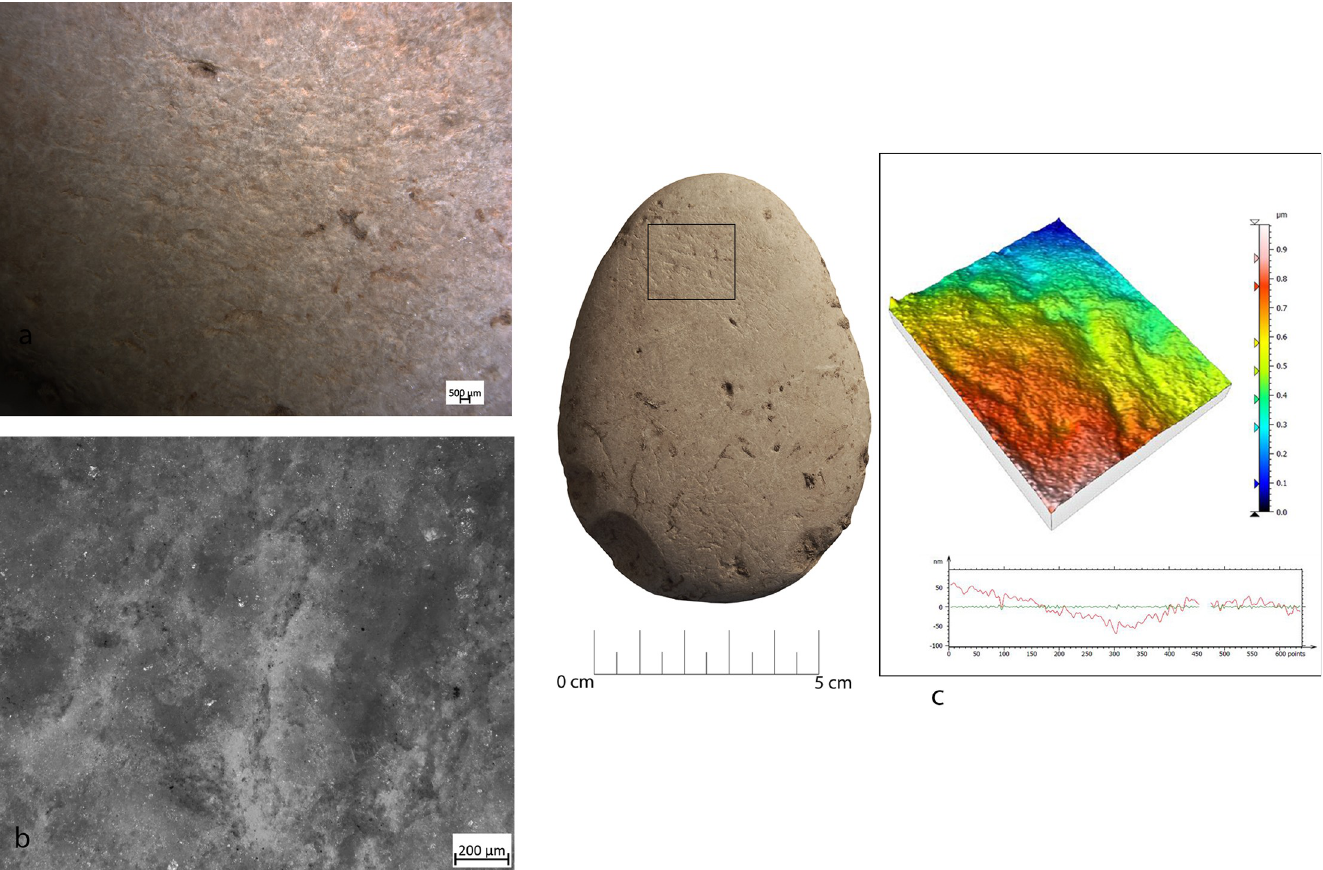
Fig 23. Use wear identified on artefact RF67. (a) Macro-traces (10x), contiguous pits of linear form (half-moon), with rough bottom and triangular section, located on the centre of apical area; (b) micro-traces (200x) are absent; (c) 3D microtopography of the used surface and